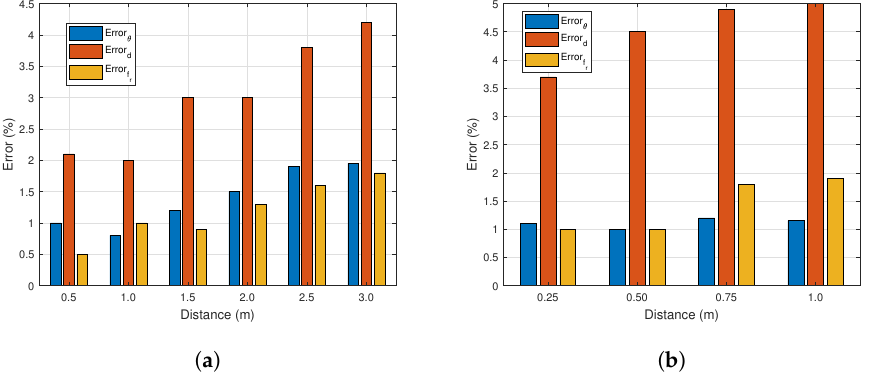
Figure 14. Error analysis with respect to the distance: ( a ) without obstacle, ( b ) with obstacle.